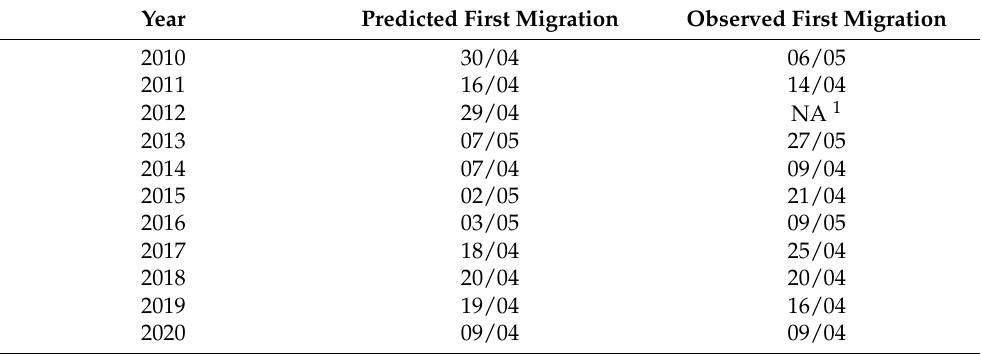
Table 2. Predicted start of migration of E. lanigerum “crawlers” (=new first instar virginoparae) and observed dates of first migration activity in apple orchards monitored in this study.